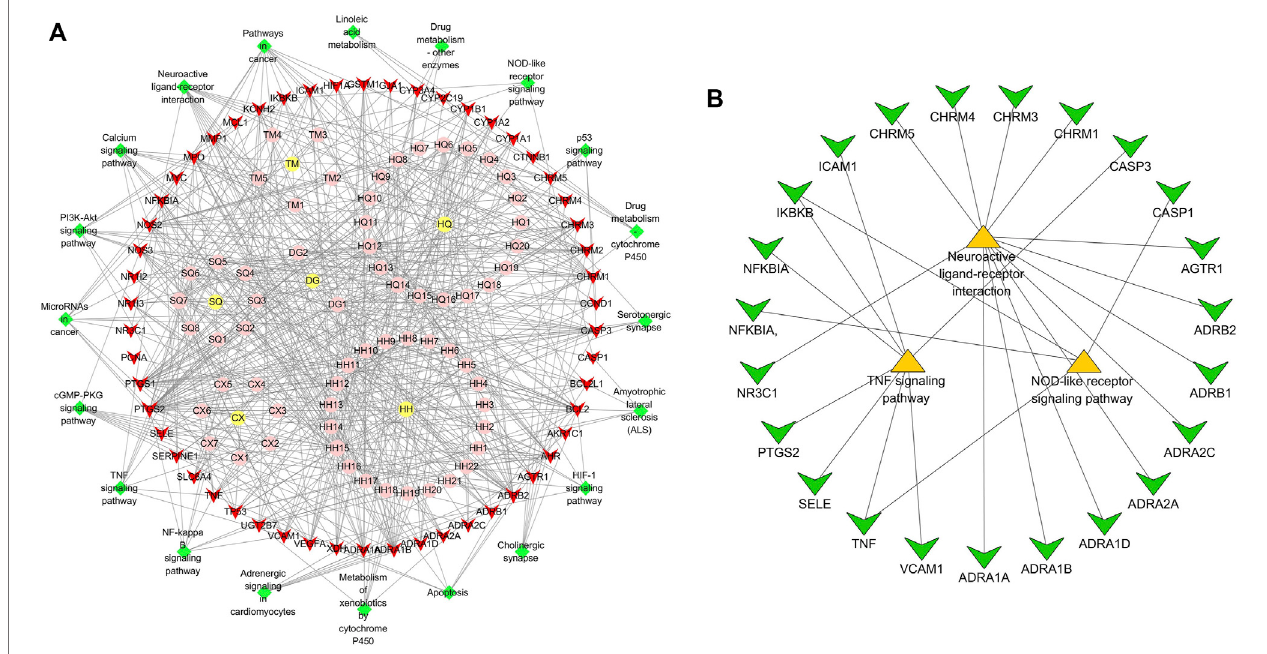
FIGURE 2 | “ Component-target-pathway ” network (A) and “ neuroin fl ammatory-pathway-target ” sub-network (B) analysis of